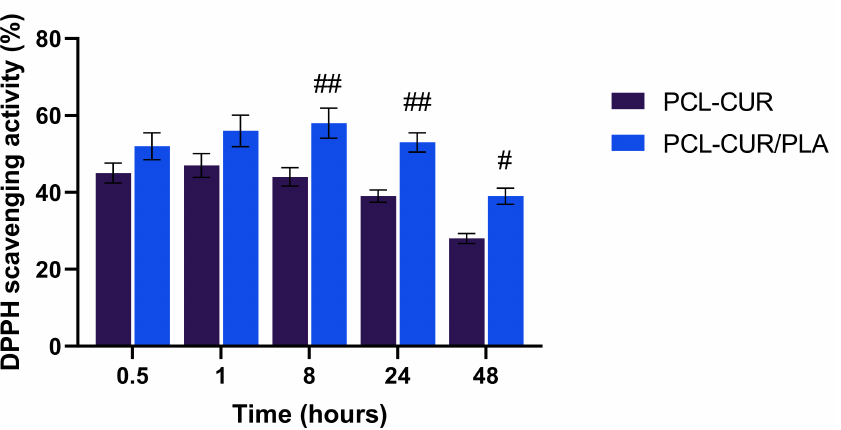
Figure 8. DPPH scavenging activity of Cur loading membranes. For each sample, six different experiments were conducted, and the results expressed as the mean of the values obtained (mean ± SD). Statistically significant variations: ## p < 0.005 versus PCL-Cur; # p < 0.05 versus